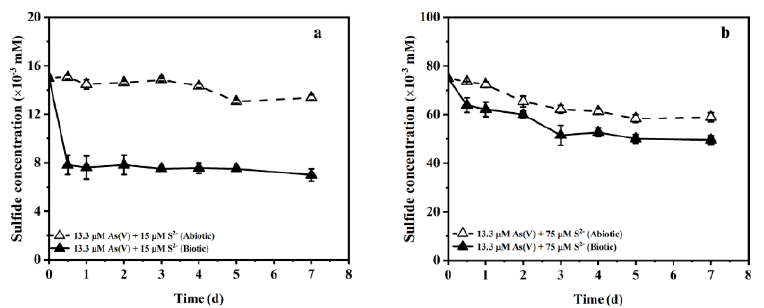
Figure 3. Changes in sulfide concentration in the medium with 15 mM ( a ) or 75 mM ( b ) initial sulfide input.